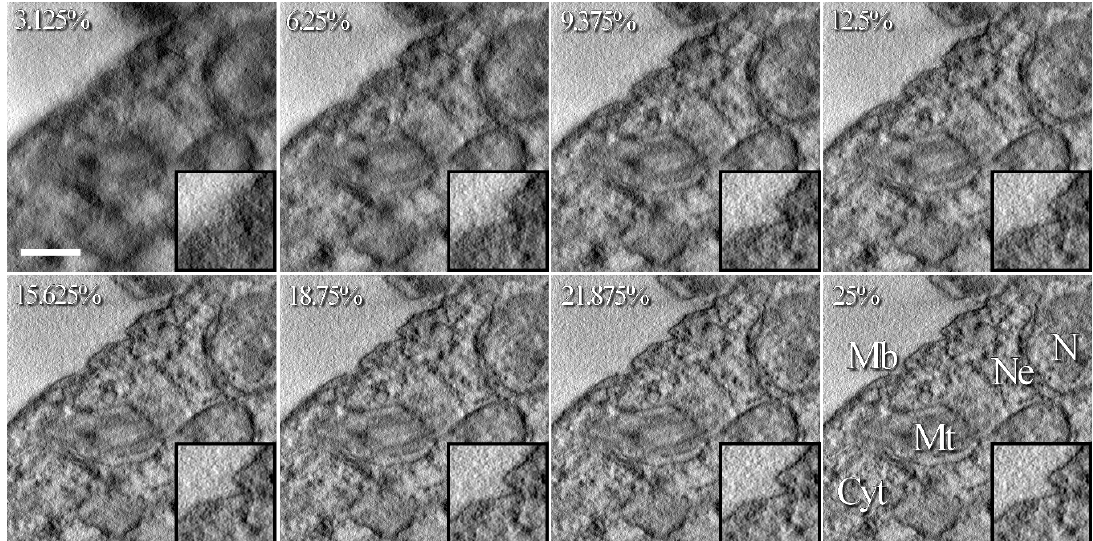
Figure 5. Comparison of 3D volumes reconstructed from sparse images collected at different downsampling values. The central Z-slice of each reconstruction is displayed. The value in the top left corner of each image corresponds to the downsampling value. Inserts in the bottom right corner are zoom-ins of the cell membrane. Several cellular structures are pointed out: the cytoplasm (Cyt), microtubules of the flagellum (Mt), the cell membrane (Mb), the nucleus (N) and the nuclear envelope (Ne). The scale bar is 400 nm. The eight subfigures have the same scale.